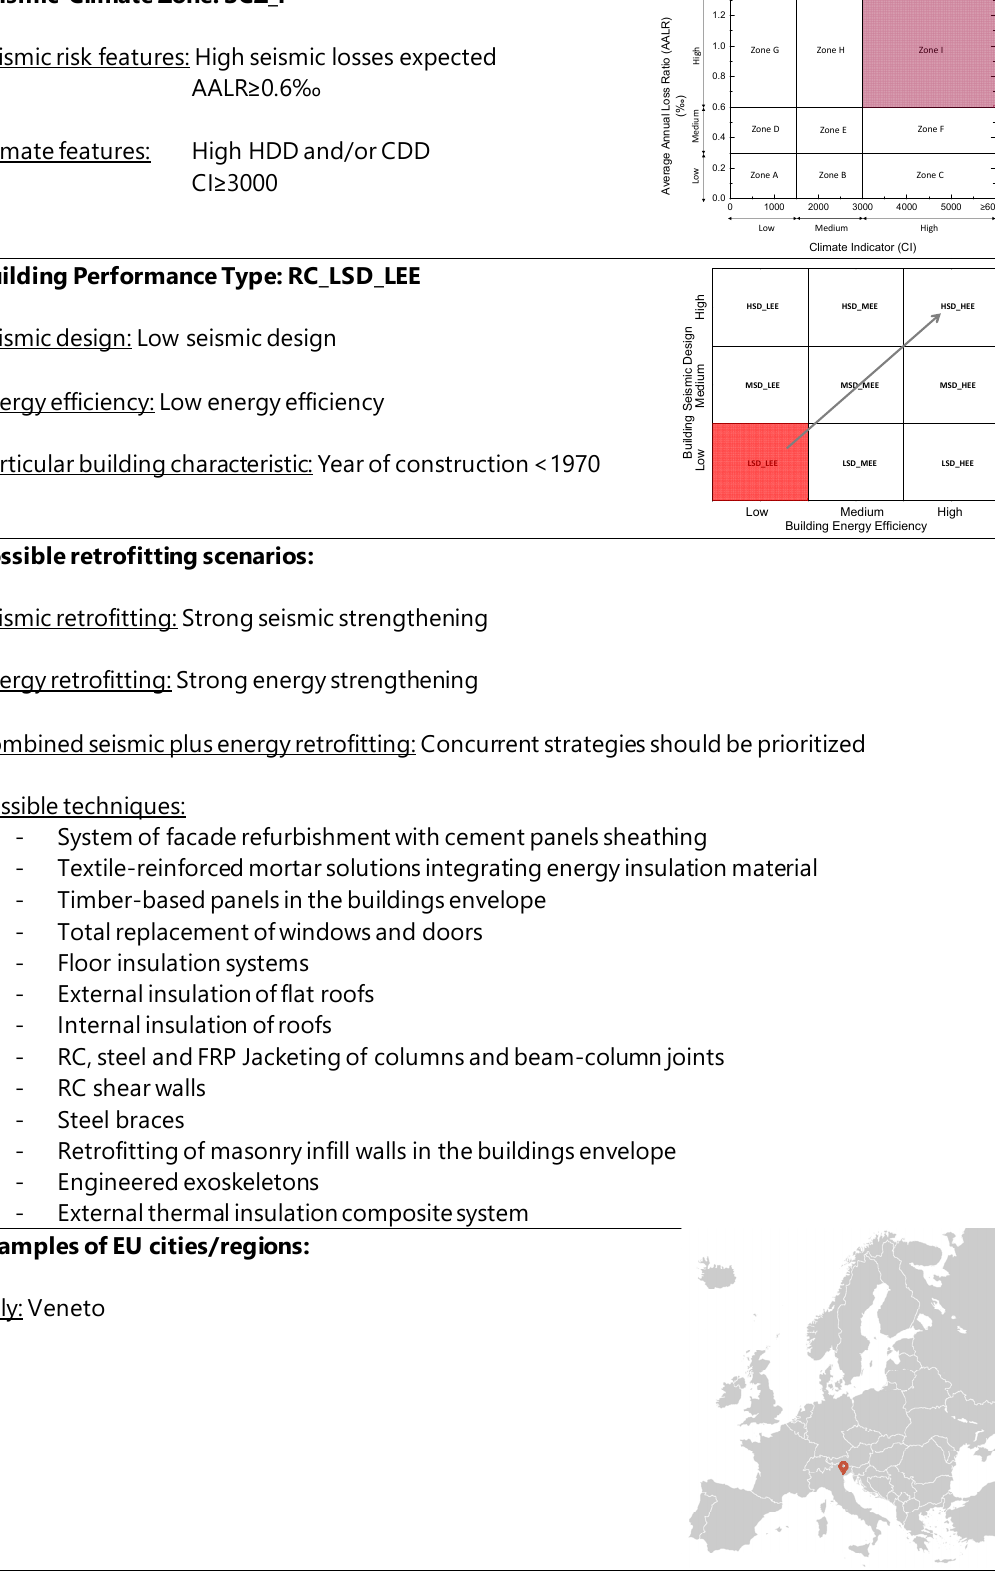
Figure 16. Retrofitting scenario 6: SCZ_I and RC_LSD_LEE.